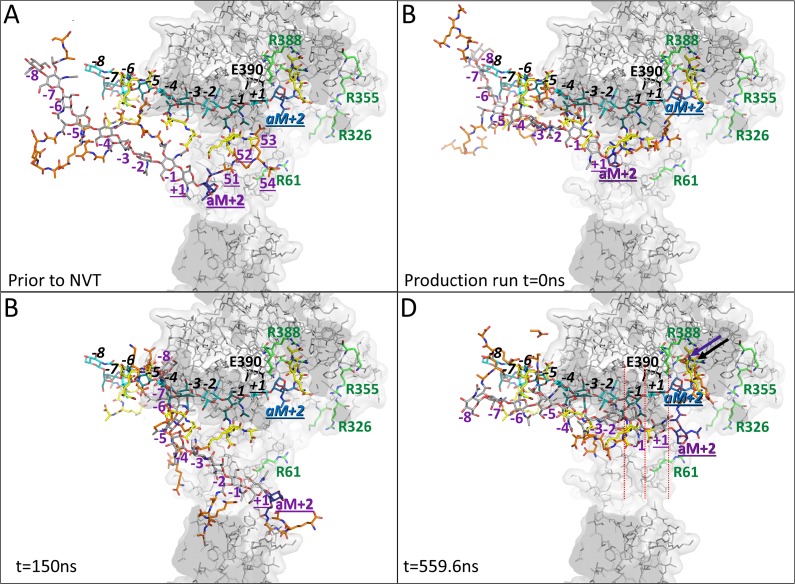
MD snapshots of the 5 disaccharide unit PG strand in the active site of Cj0843 as part of the 1μs simulation.A The starting position and starting conformation of the PG strand after minimization but before the NVT. The tetrapeptide moieties of the terminal disaccharide unit of the PG strand are labeled ‘51’ through ‘54’. The GlcNAc and MurNAc moieties are shown with grey carbon atoms whereas the tetrapeptide moieties are shown with orange colored carbon atoms; these PG moieties are labeled in purple. For reference, this and subsequent snapshots also contains a PG strand in the active site as obtained from the simulations with the PG in the substrate-binding mode (same binding mode and coloring as in Fig 6A yet with black italicized labels). The 1,6-anhydroMurNAc moiety is colored darker and labeled bold ‘aM+2’ for both PG strands in each panel. The labels of the moieties of the terminal disaccharide unit to be cleaved off in both the MD PG strand and the reference PG substrate strand are underlined. Residue E390 is labeled and shown in black sticks, and the Arg/Lys residues are shown with green carbon atoms as in Fig 6. The view is slabbed showing a side view that is roughly in a similar orientation as Fig 1B. B The PG strand after the NVT and NPT equilibration step but before the production MD run. C Snapshot at 150ns showing the PG has entered the pore but is bound unproductively distant from the active site E390. D Snapshot at 559.6ns showing that the terminal tetrapeptide section has reached the positively charged pocket 2 and makes similar carboxyl interactions as the equivalent tetrapeptide section in the comparison substrate modeled PG strand (arrows). At this latter time point, the glycan strand has approached the active site the closest within the entire 1μs simulation; the nitrogen of the N-acetyl moiety of GlcNAc-2 residue is within 7Å the Y463 main chain oxygen. Also, the anchoring in pocket 2 lined up the correct MurNAc-1 and GlcNAc+1 with respect to their equivalent moieties in the substrate-binding mode (red dashed lines) to facilitate cleavage of the terminal disaccharide PG unit pending the final approach to the active site groove.